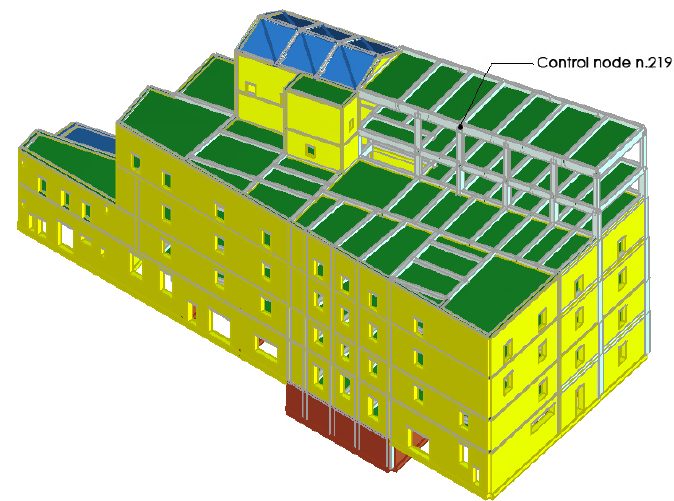
Figure 15. Choice of control